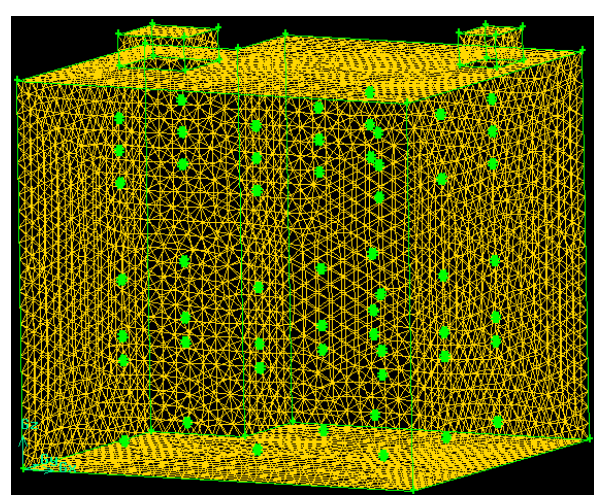
Figure 16. Sensor installation.